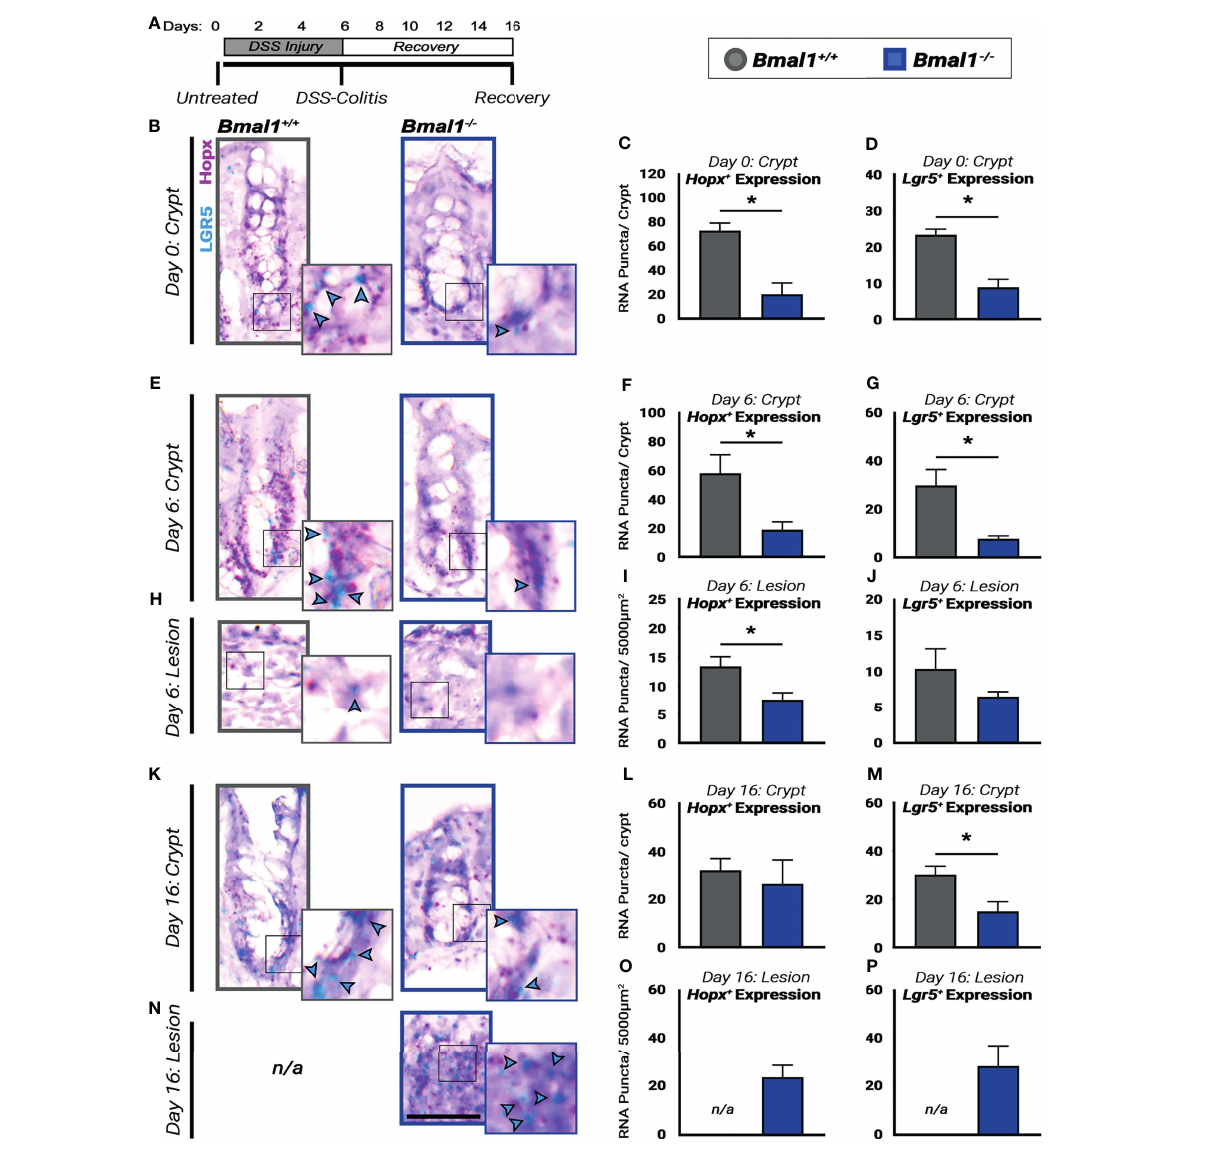
FIGURE 8 | Regenerative pathways are disrupted and decreased in Bmal1 -/- mutant mice. (A) Experiment schematic: Bmal1 +/+ control and Bmal1 -/- mutant mice were collected before DSS treatment (Day 0), after 6 days of 4% DSS treatment to induce colitis (Day 6) and following 10 days of recovery after DSS removal (Day 16). (B) Representative images of sections probed for transcriptional expression of the fetal-like regenerative precursor marker Hopx (in pink), and the ISC marker Lgr5 (in blue, highlighted with blue arrow heads) in untreated (Day 0) Bmal1 +/+ control and Bmal1 -/- mutant mice. Bmal1 -/- mutants show decreased levels of both (C) Hopx and (D) Lgr5 markers in untreated mice. (Unpaired t- test, Hopx *p= 0.0091, Lgr5 *p= 0.0062). (E) Representative images of crypts probed for transcriptional expression of Hopx , and Lgr5 in DSS-colitis treated (Day 6) Bmal1 +/+ control and Bmal1 -/- mutant mice. (F) Upon colitis induction at Day 6, Bmal1 -/- mutant mice exhibit a decrease in Hopx in crypts. (Unpaired t- test, Hopx *p=0.0491). (G) Bmal1 -/- mutant mice exhibit a decrease in Lgr5 in crypts. (Unpaired t- test, Lgr5 *p=0.0301). (H) Representative images of lesions probed for transcriptional expression of Hopx , and Lgr5 in DSS-colitis treated (Day 6) Bmal1 +/+ control and Bmal1 -/- mutant mice. (I) Lesions of Bmal1 +/+ control mice also show decreased Hopx expression. (Unpaired t- test, Hopx *p=0.0489). (J) Lesions of Bmal1 +/+ control and Bmal1 -/- mutant mice show low but similar Lgr5 expression. (Unpaired t- test, p=0.2521). (K) Representative images of crypts probed for transcriptional expression of Hopx , and Lgr5 following 10 days of recovery (Day 16) Bmal1 +/+ control and Bmal1 -/- mutant mice. (L) After 10 days of recovery, Bmal1 -/- mutant mice exhibit similar Hopx expression in crypts. (Unpaired t- test, p=0.66226). (M) Bmal1 -/- mutant mice exhibit a decrease in Lgr5 in crypts. (Unpaired t- test, *p= 0.0468). (N) Representative images of Bmal1 -/- mutant lesion sections probed for transcriptional expression of Hopx , and Lgr5 following 10 days of recovery (Day 16). Sections labeled not/applicable (n/a) indicate that lesions were not present in Bmal1 +/+ control mice. (O) Quanti fi cation of Hopx expression in Bmal1 -/- mutant lesions following 10 days recovery. (P) Quanti fi cation of Lgr5 expression in Bmal1 -/- mutant lesions following 10 days recovery. (All error bars represent SEM. Scale bar =